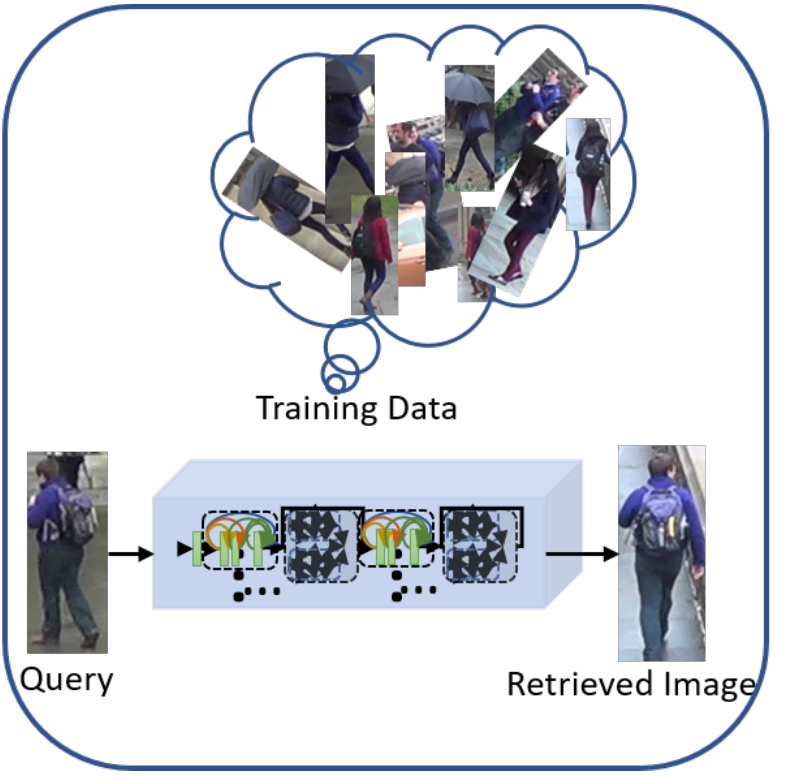
Figure 1. The query image is to be re-identified through the trained model. The training data shows the sample images of the dataset where pictures captured across multiple cameras are